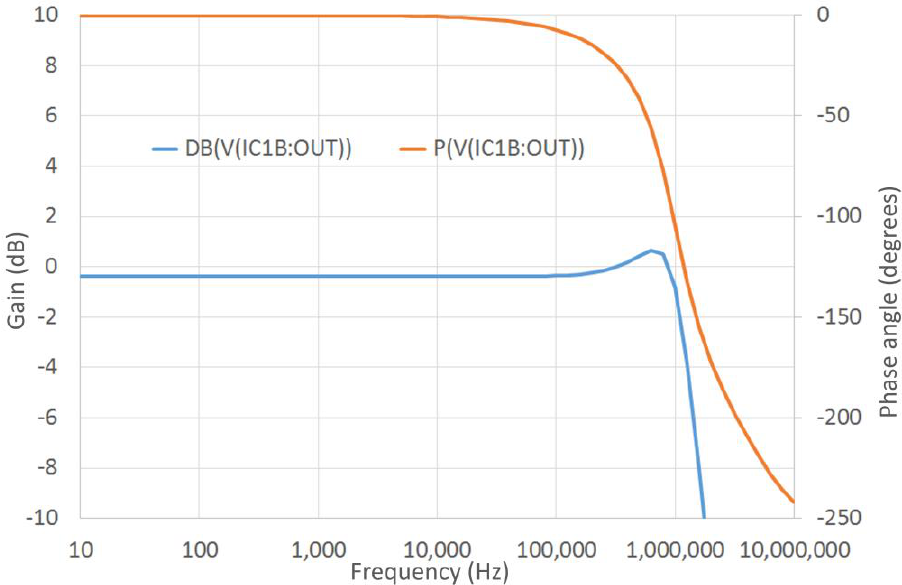
Figure 14. Simulation results of the line voltage circuit simulation frequency response: bandwidth ( V out / V in ) 10 Hz – 10 MHz.